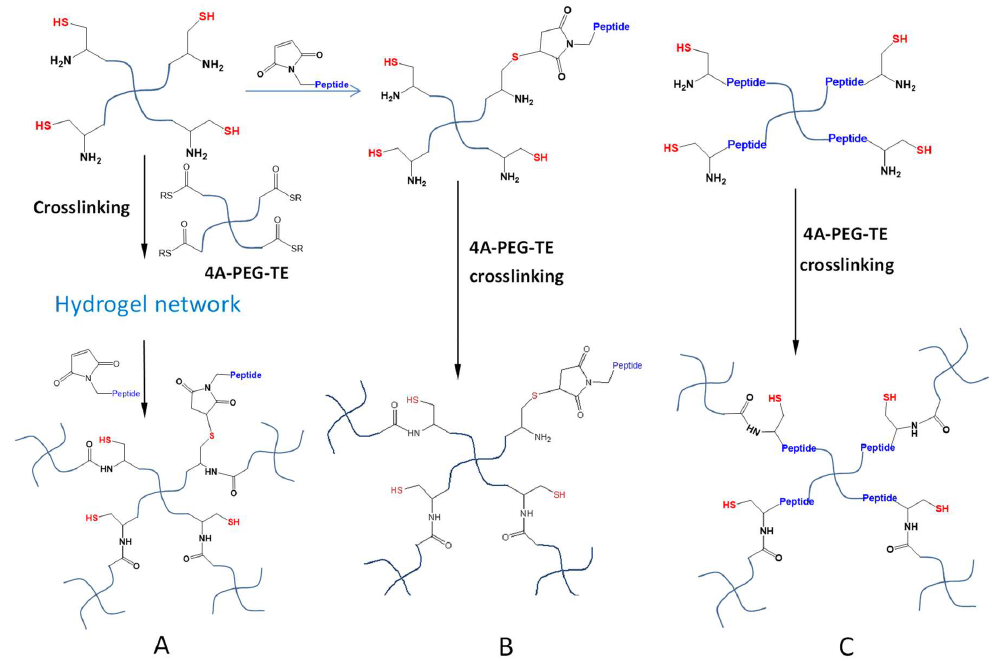
Figure 11. Functionalization of NCL hydrogels. ( A ) The hydrogel network crosslinked by the NCL reaction presents thiols that can react with maleimide-attached peptides (or other bioactive molecules) post-gelation. ( B ) Maleimide-attached molecules can be conjugated to thiol-polymers prior to NCL crosslinking. ( C ) Molecules of desired properties can be synthetically inserted into the thiol-polymers or thioester-polymers to form functional NCL hydrogels.